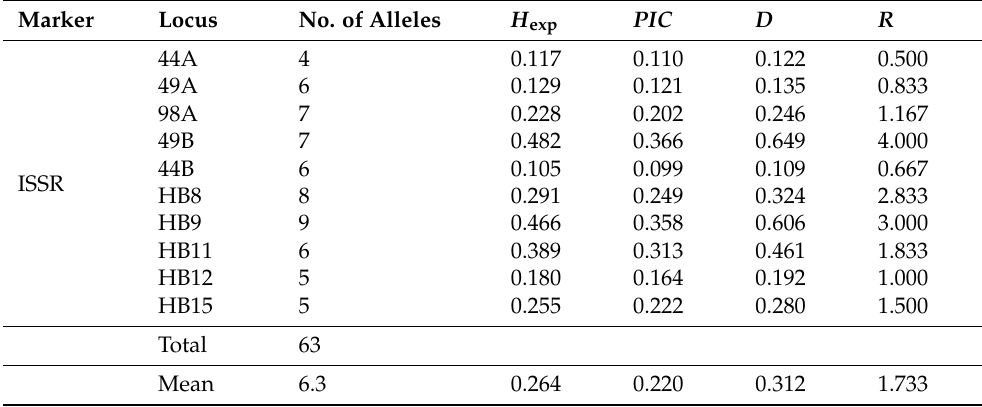
Table 7. Polymorphism of ISSRs and SSRs in 12 rice genotypes.